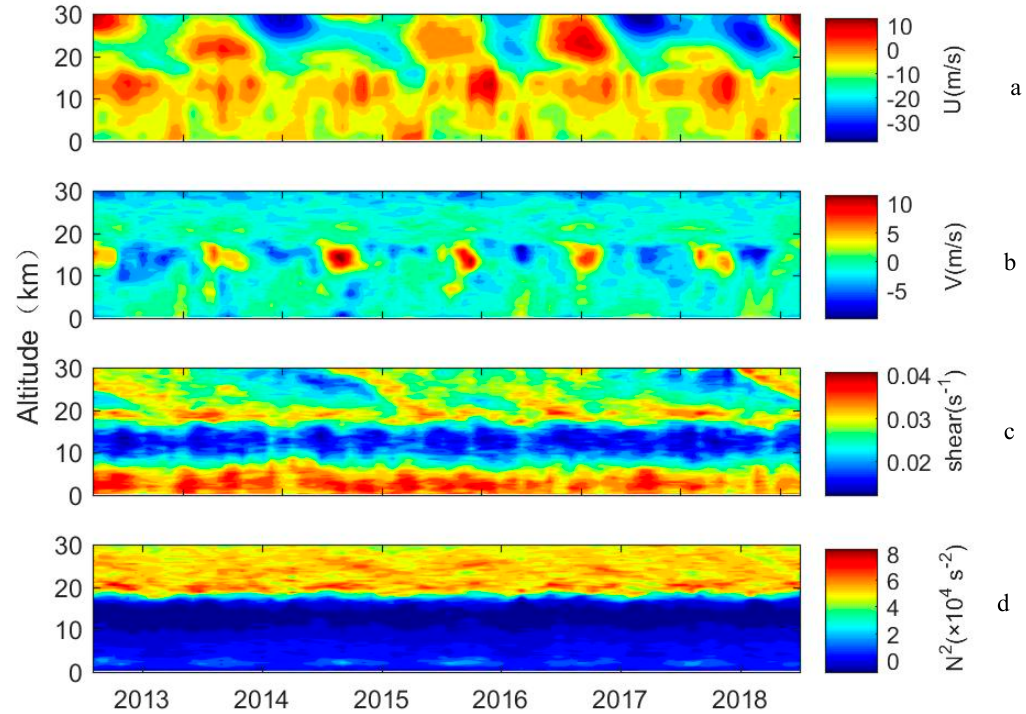
Figure 5. The monthly averaged ( a ) zonal wind, ( b ) meridional wind, ( c ) shear, ( d ) squared Brunt– Figure5. Themonthlyaveraged( a )zonalwind, ( b )meridionalwind, ( c )shear, ( d )squaredBrunt–Väisälä Väisälä frequency from 2013–2018. frequency from